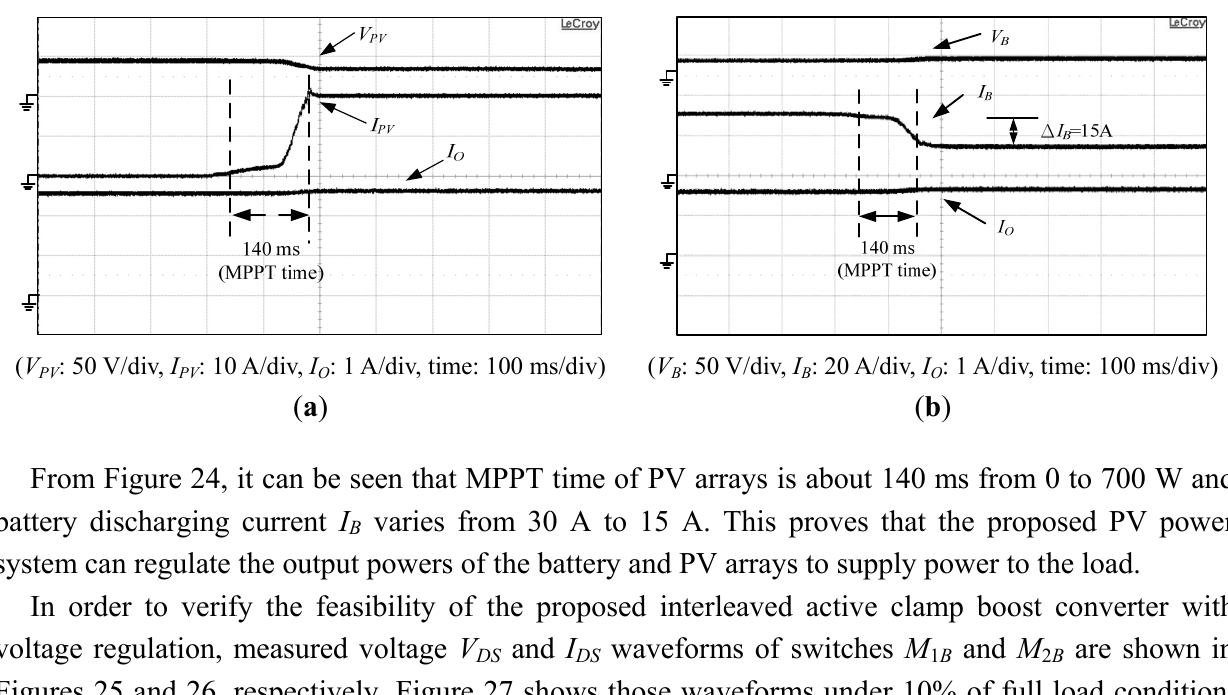
and charge current I waveforms of battery under B BC